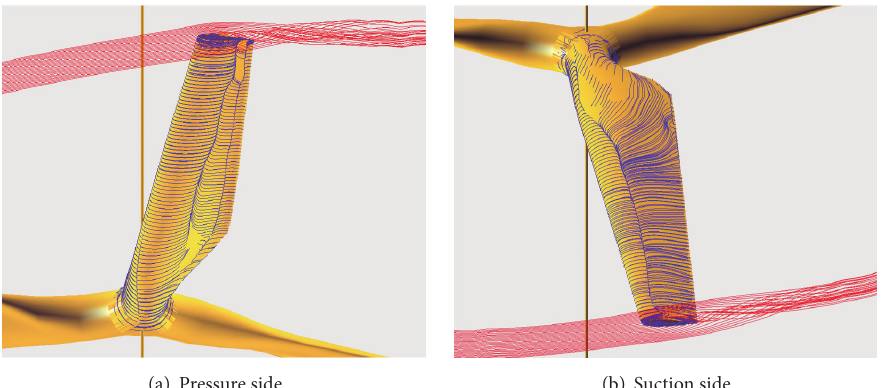
Figure 16: Limiting streamlines on blade surface solved by the unsteady laminar model ( Δ𝑡 = 1/16000 rotation) for 𝜆 = 6 .